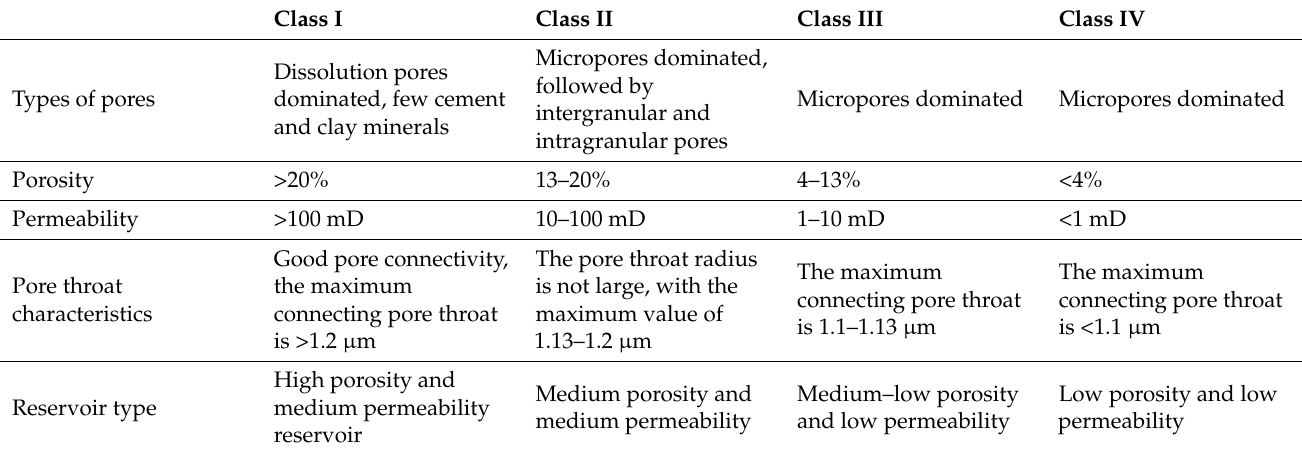
Table 1. Classification of clastic rocks reservoir considering pore throat